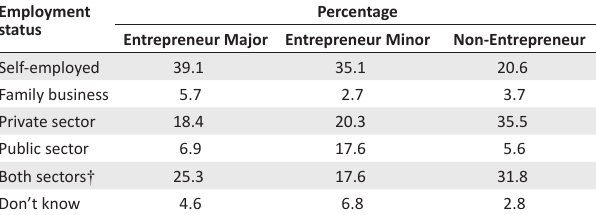
TABLE 3: Employment status after two years.